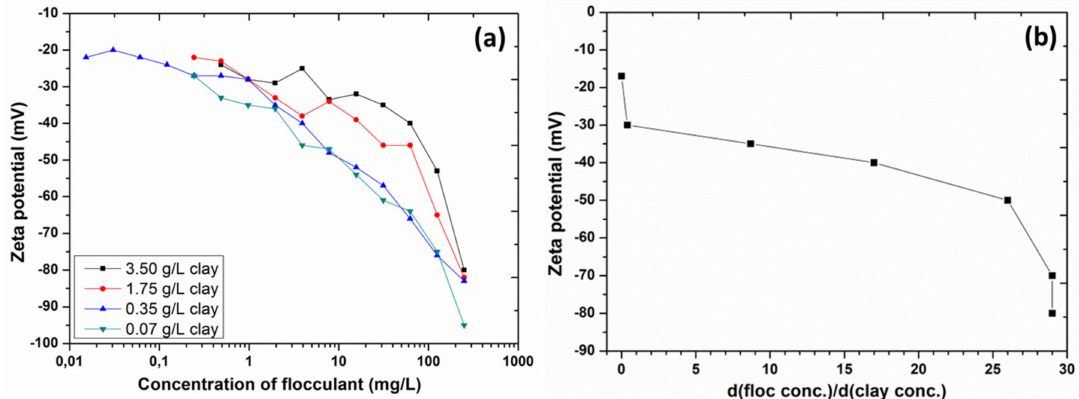
Figure 11. ( a ) Zeta potential as a function of anionic flocculant concentration for di ff erent concentrations of clay and ( b ) zeta potential as a function of flocculant to clay